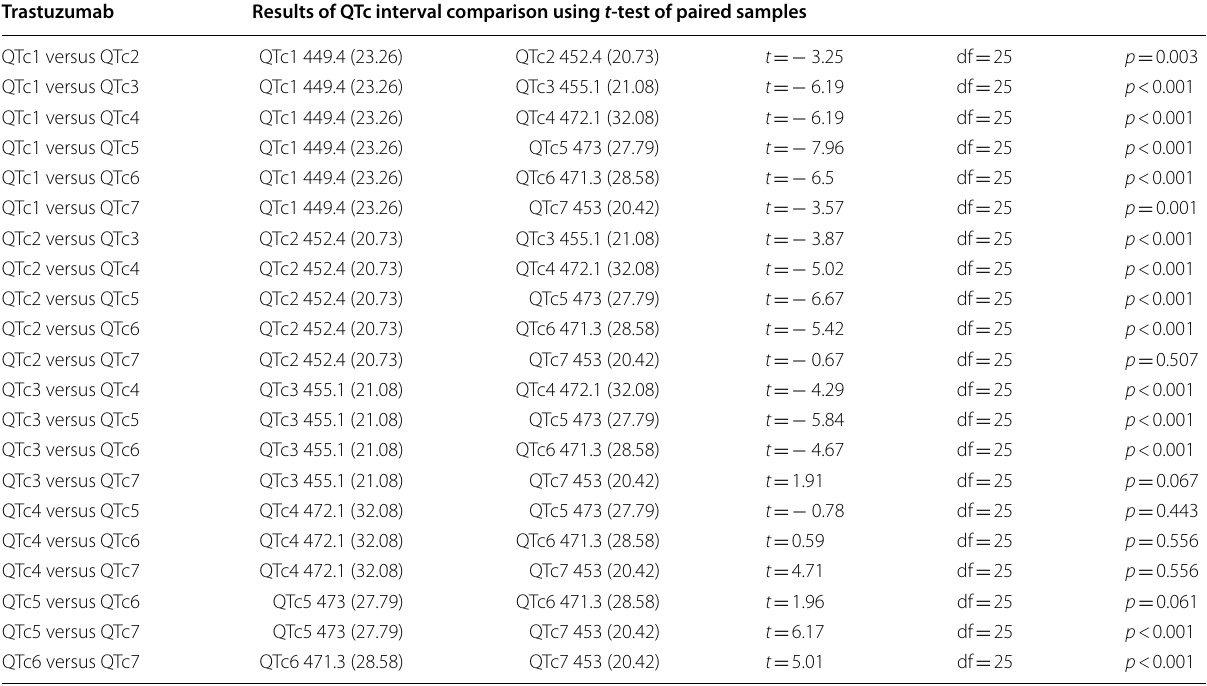
Student’s t -test of paired samples was also used to compare QTc interval values obtained before each trastuzumab emtansine cycle and after the last application of the drug. A statistically significant p value of < 0.05 was used